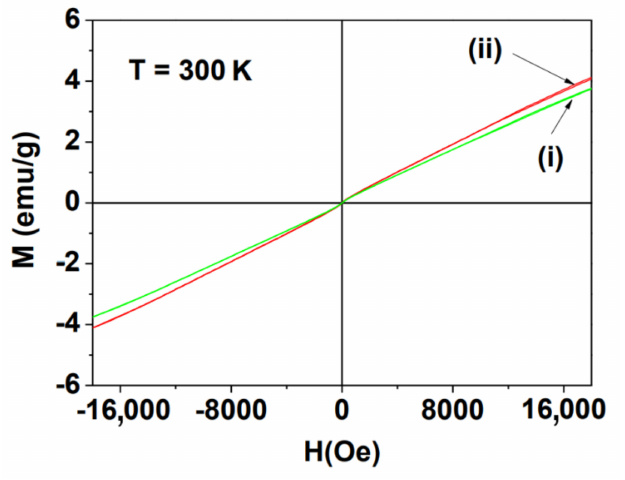
Figure 6. M − H curves of the PAA-coated Ln 2 O 3 NPs at 300 K [Ln = (i) Tb and (ii) Ho]. Net M values of the Ln 2 O 3 NPs (i.e., without PAA) estimated from TGA curves were used in the plots.